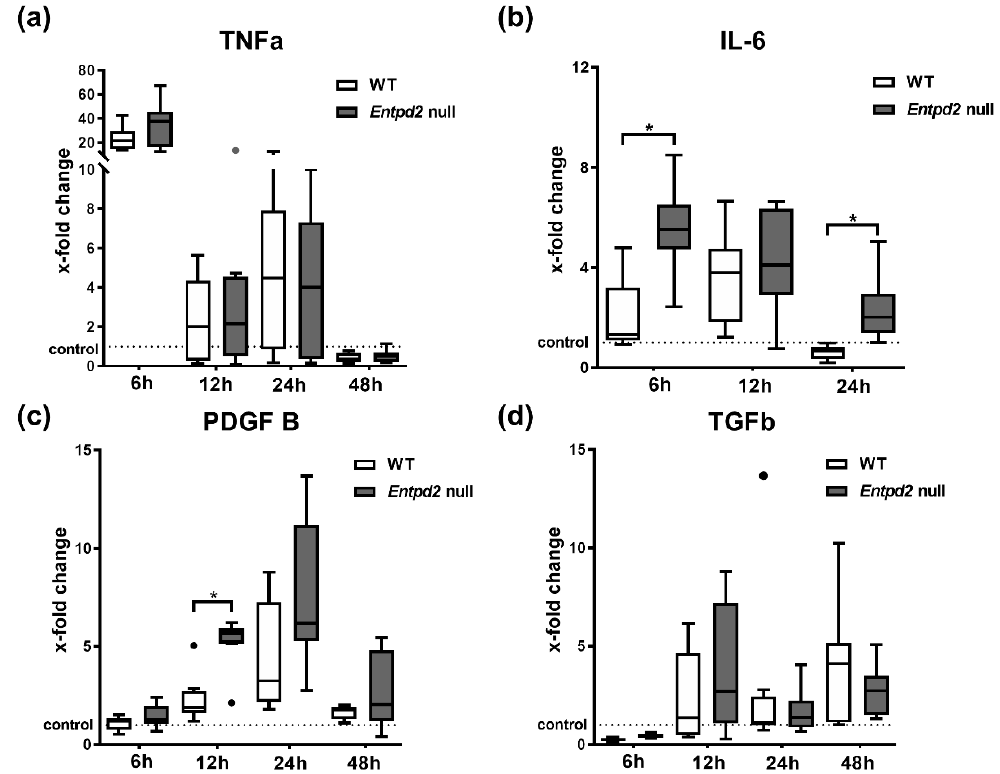
Figure 4. Hepatic expression of pro-inflammatory and pro-regenerative cytokines after APAP intoxication. qRT-PCR analysis of total mRNA isolated from mice livers after APAP intoxication. Data are shown as fold-changes of mRNA expression relative to vehicle-treated WT controls of ( a ) tumor necrosis factor (TNF- α ), ( b ) interleukin-6 (IL-6), ( c ) platelet-derived growth factor-B (PDGF-B), and ( d ) transforming growth factor (TGF- β ). * p < 0.05.